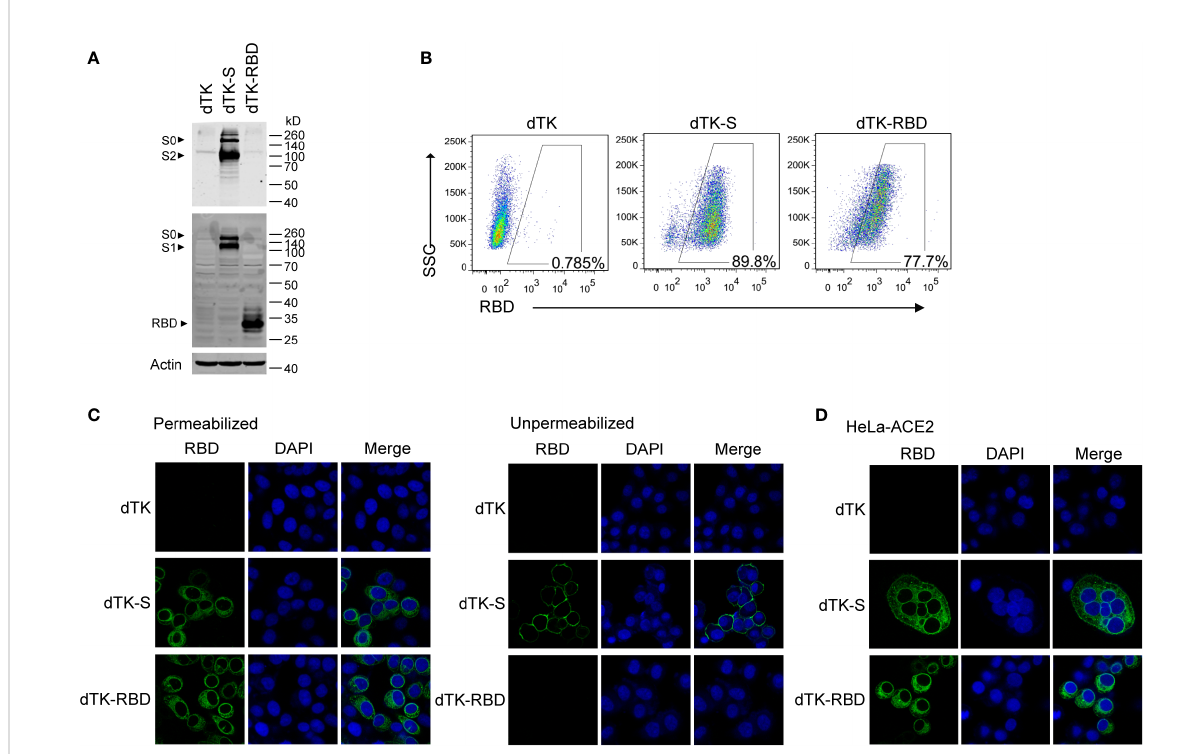
FIGURE 2 Expression of RBD and spike protein in cells infected by the recombinant VACV. (A) Vero cells were infected with parent VACV dTK, dTK-S, or dTK-RBD (MOI 0.01) for 24h. Cell lysates were analyzed by Western blotting using S2 or RBD-speci fi c antibodies. (B) Vero cells were infected with VACV dTK, dTK-S, or dTK-RBD (MOI 0.05) for 24h. Cells were permeabilized and stained with anti-RBD antibody, followed by Alexa Fluor 488-conjugated donkey anti-rabbit antibody incubation. Percentages of FITC-positive cells were shown. (C) Immuno fl uorescence staining of HeLa cells infected with VACV dTK, dTK-S, or dTK-RBD (MOI 0.05) for 24h. Cells were fi xed with 4% paraformaldehyde, permeabilized with 0.2% Triton X-100, or stained directly with anti-RBD antibody. Nuclei were stained by DAPI. (D) Immuno fl uorescence staining of syncytia formed by HeLa cells expressing human ACE2 (HeLa-ACE2). HeLa-ACE2 cells were infected with VACV dTK, dTK-S, or dTK-RBD (MOI 0.05) for 24 h, fi xed, permeabilized, and stained with anti-RBD antibody. Nuclei were stained by DAPI. RBD, receptor-binding domain; VACV, vaccinia virus; dTK-S, vaccinia virus-expressing spike protein; dTK-RBD, vaccinia virus-expressing receptor-binding domain; MOI, multiplicity of infection; FITC, fl uorescein